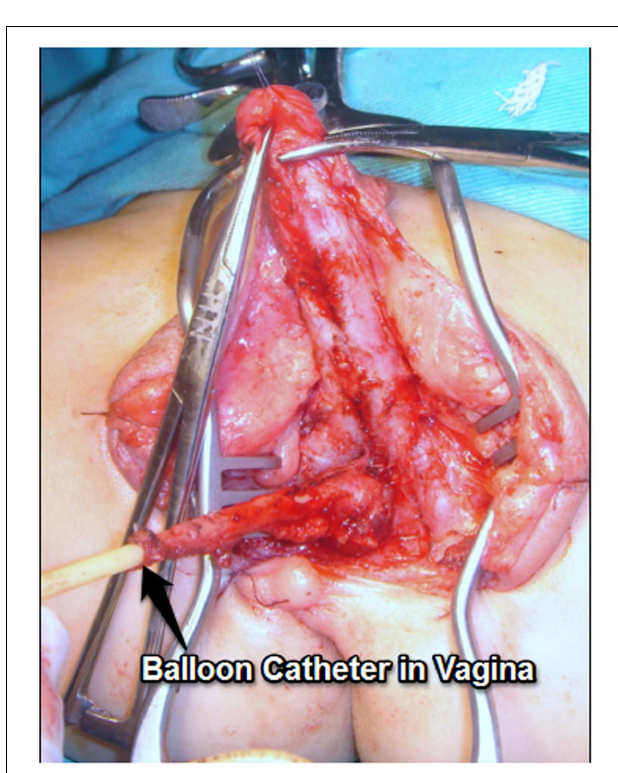
FIGURE 4 | Mobilization the UGS in the lithotomy position without opening it in a high variant . A balloon catheter has been previously inserted in